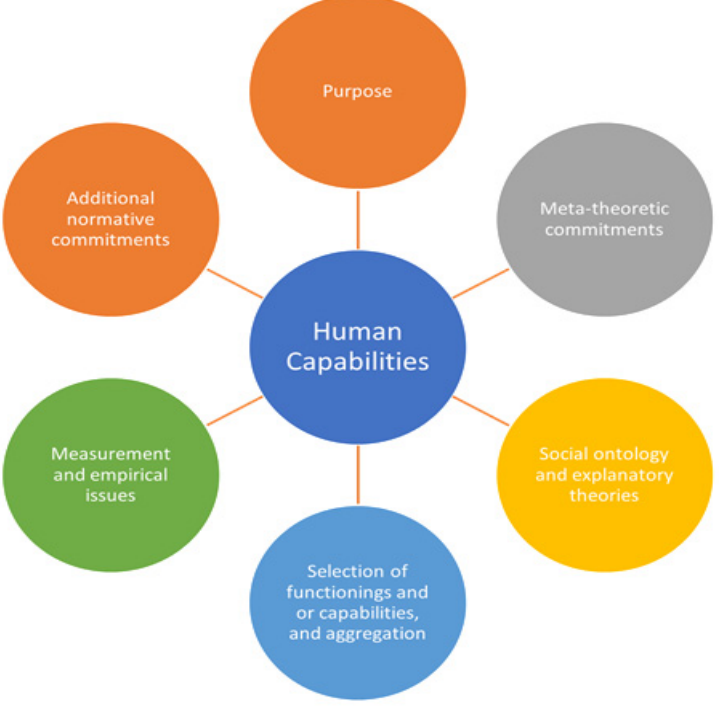
Figure 2. Cartwheel view of the HCA (adopted from [56]).